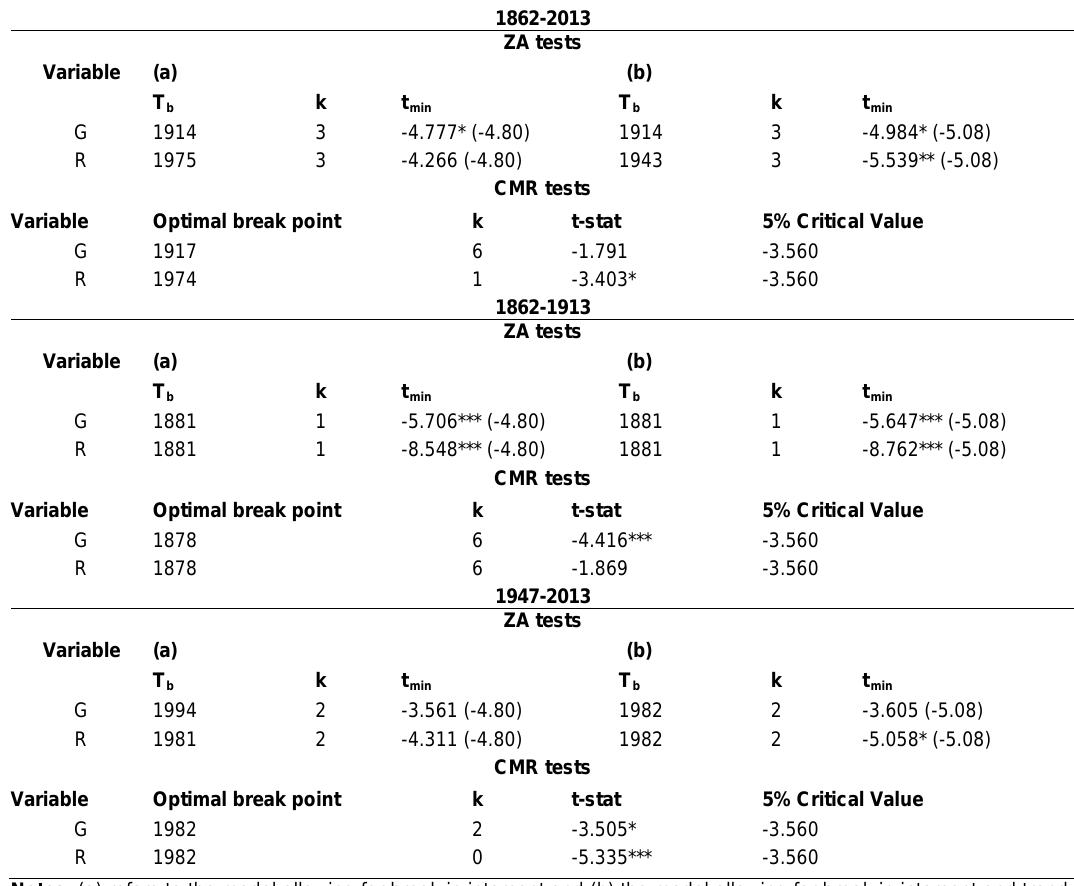
Table 3 : Results for unit root tests with structural breaks and for additive outlier unit root tests (single structural break).